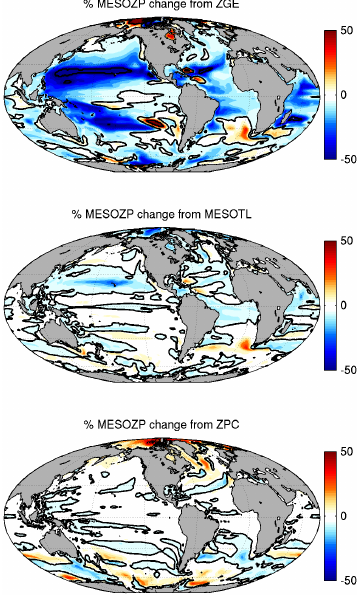
Figure 7. Contribution to percent of change in MESOZP due to evolving planktonic food web properties. Adding the changes above to the percent of change in NPP (Fig. 2b) yields the approximation of the percent of MESOZP change in Fig. 6. The 0 contour is shown in all figures.